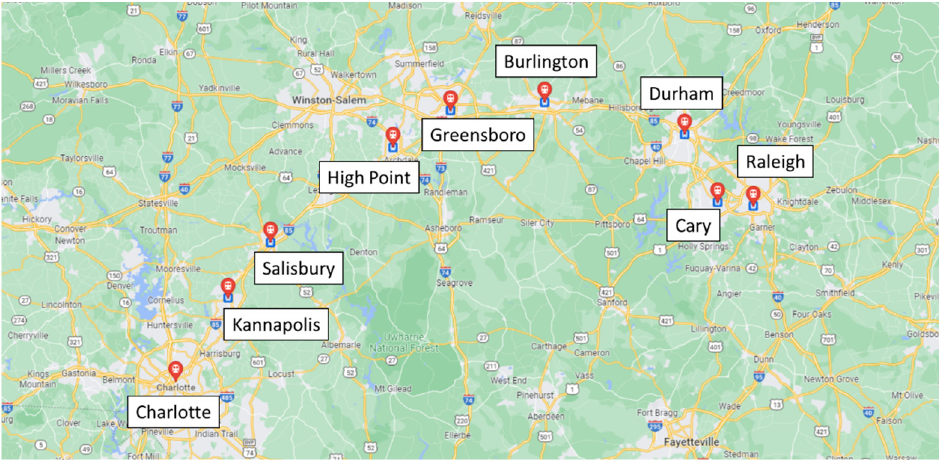
Figure 2. Map of train stations (source: 2023 Google Maps). Table 2. Energy consumption summary.